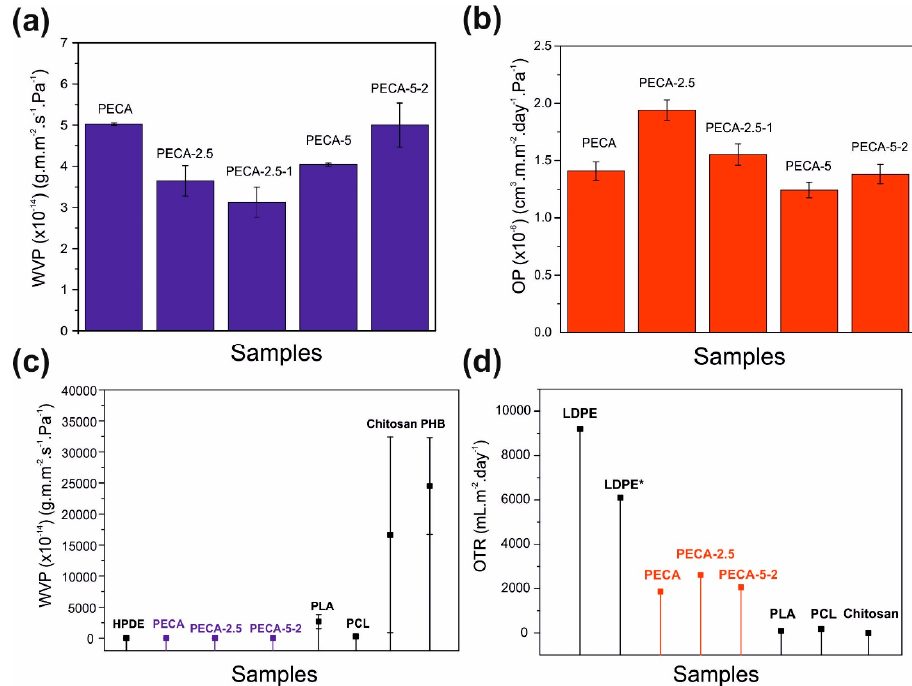
Figure 7. ( a ) Water vapor permeability and ( b ) oxygen permeability results of all films. All data represent the mean ± SME of three measurements. ( c ) Comparison of water vapor permeability (WVP) and ( d ) oxygen transmission rate with other polymers: high-density polyethyelene (HDPE) [64], poly(lactic acid) (PLA) [67,68], polycaprolactone (PCL) [66,69], chitosan [42,66], polyhydroxybutyrate (PHB), low-density polyethylene (LDPE), LDPE with 1% wt. of linanool (LDPE*) [64].